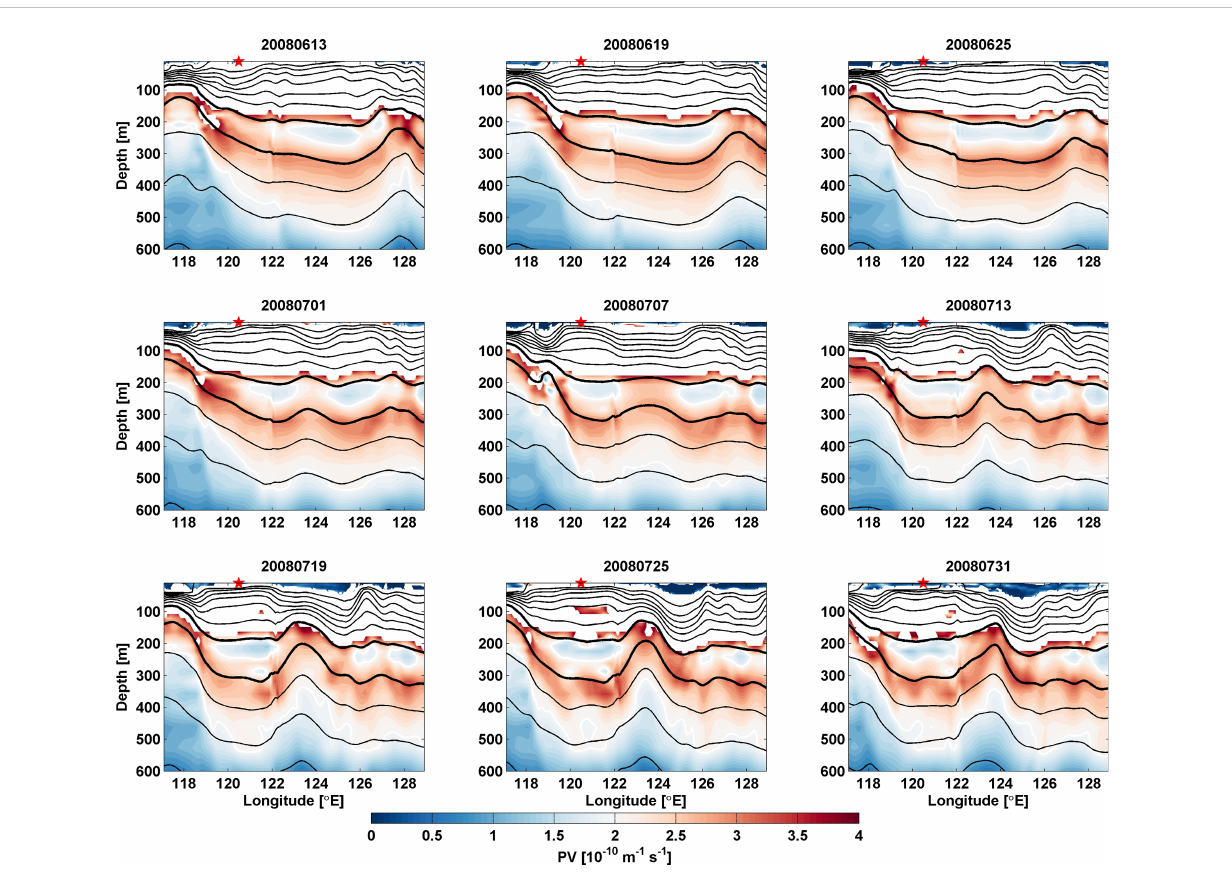
The process of an AE forming west of the Luzon Strait and then isolating a low PV signal (colors, unit: 10 − 10 m − 1 · s − 1 ) from the AE along 21°N to the east in the 2008 case. The white lines denote the 2 (cid:1) 10 − 10 m − 1 · s − 1 PV contour. The thick black lines denote the 25 : 0kg · m − 3 and 25 : 5kg · m − 3